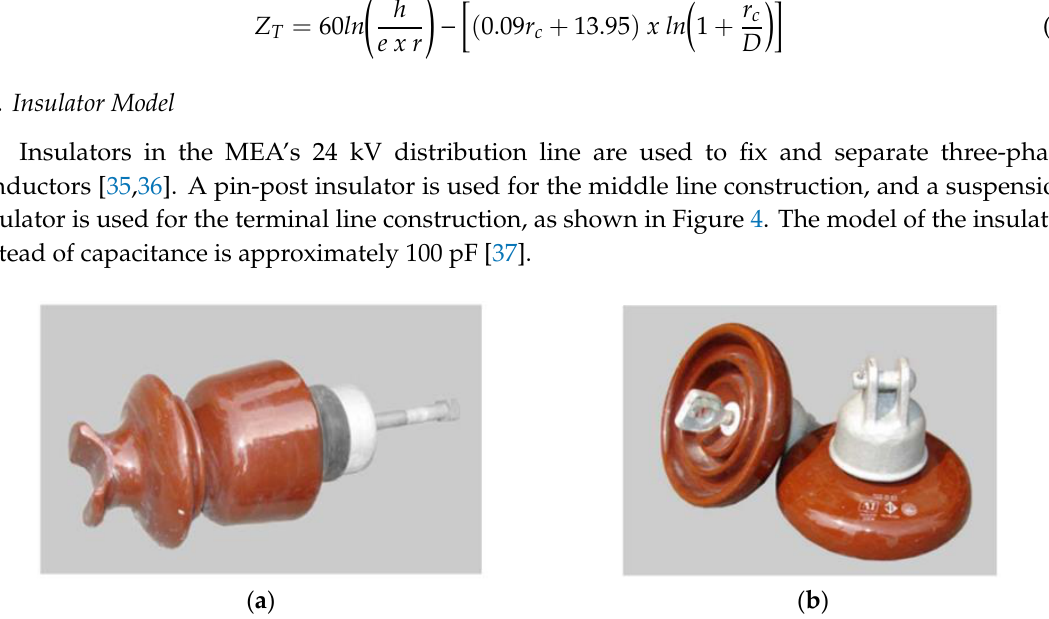
Figure 4. Electrical insulators used in the Metropolitan Electricity Authority’s (MEA) 24 kV distribution line; ( a ) Pin-post insulator for the middle of the line; ( b ) Suspension insulator for the end of the line.